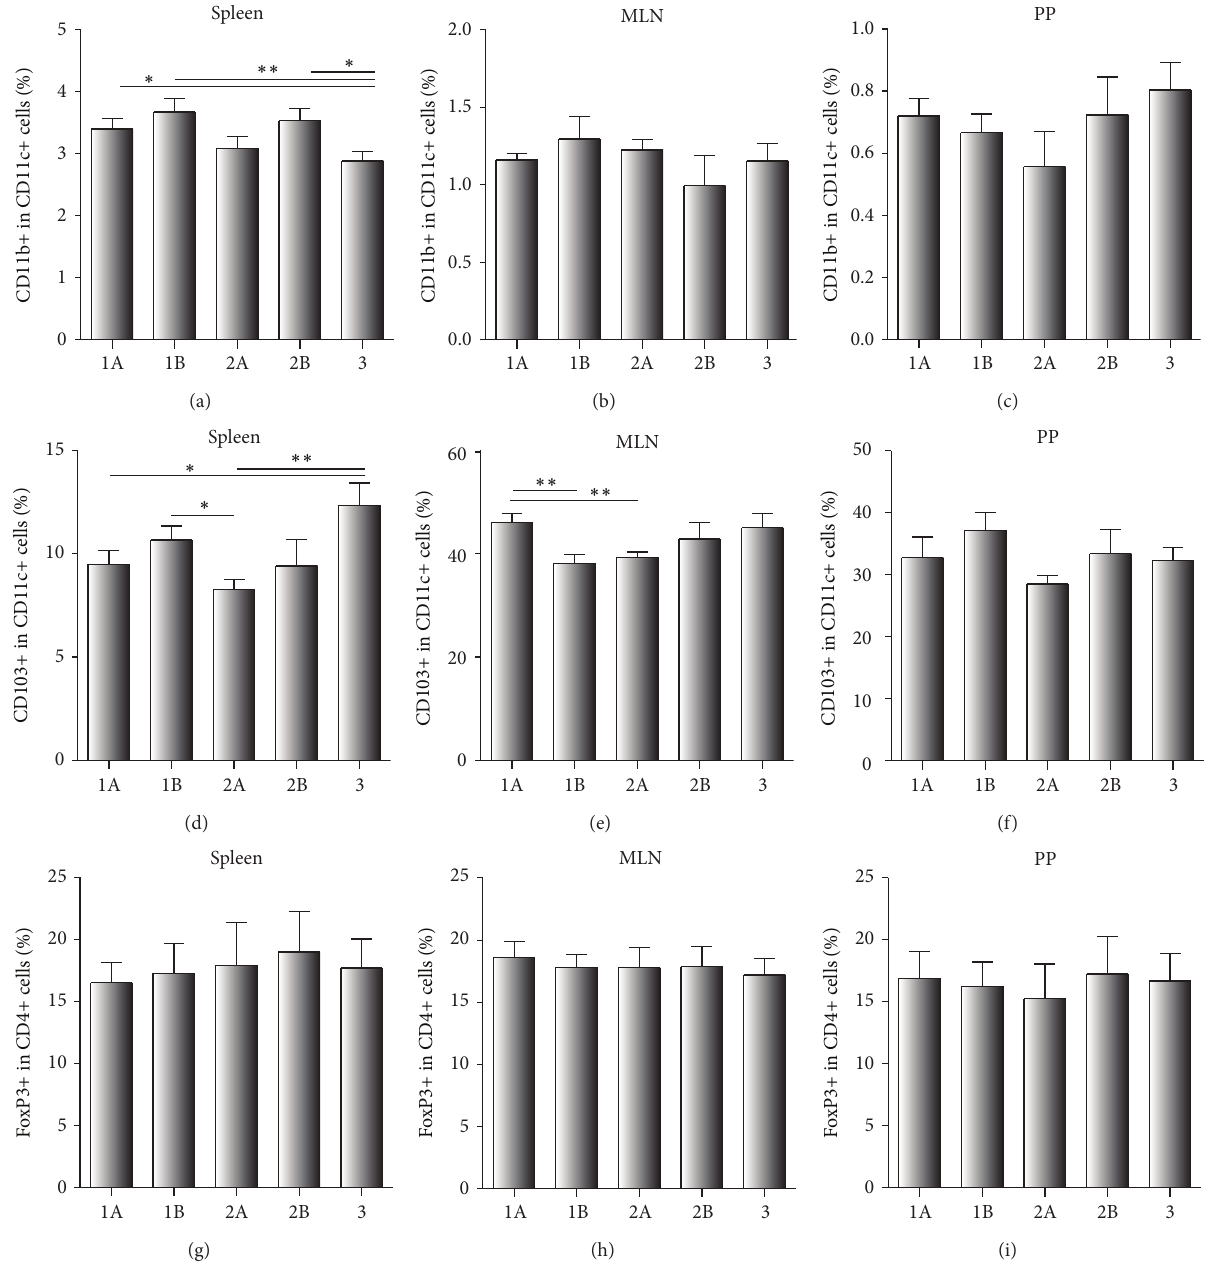
Figure 7: Flow cytometric analyses of lymphocytes isolated from the spleen, mesenteric lymph nodes (MLN), and Peyer’s patches (PP). ((a)–(c)) Percentages of CD11b positive dendritic cells (CD11c + ). ((d)–(f)) Percentages of tolerogenic CD103 positive dendritic cells. ((g)–(i)) Percentages of FoxP3 positive regulatory T cells (CD4 + ). High-fat diet (HFD) induced C57BL/6mice treated with Ampicillin from birth and until five weeks of age (1A; Ampicillin 5w+ 16w − /DIO+), or from birth and until five weeks of age followed by Ampicillin treatment from 12 to 16 weeks of age (1B; Ampicillin 5w+ 16w+/DIO+), or only from 12 to 16 weeks of age (2A; Ampicillin 5w − 16w+/DIO+) are illustrated together with untreated HFD induced mice (2B; Ampicillin 5w − 16w − /DIO+) and untreated control mice (3; Ampicillin 5w − 16w − /DIO − ). Error bars represent the SEM. ∗ ( 𝑃 < 0.05 ), ∗∗ ( 𝑃 < 0.01